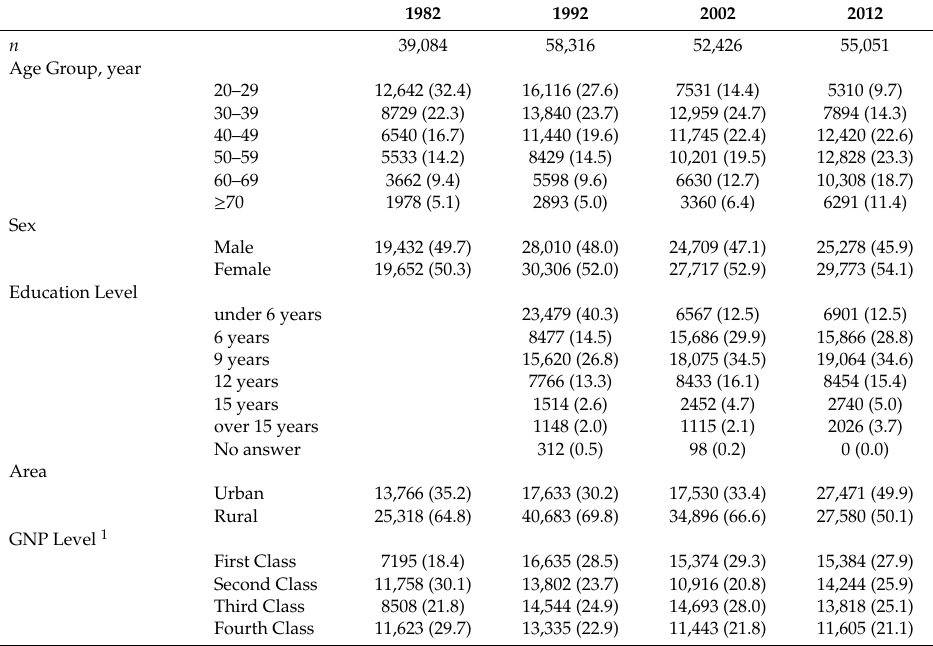
Table 1. Sociodemographic Characteristics of Participants by China National Nutrition Survey (CNNS) Rounds,